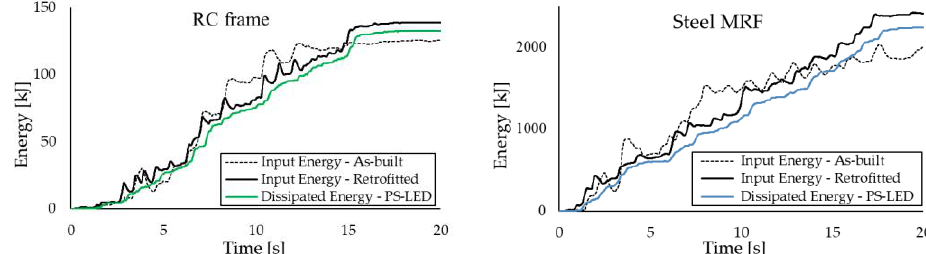
Figure 22. Comparison of energy time histories of the buildings and the total energy dissipated by the PS-LED dampers calculated for the most demanding input accelerogram.